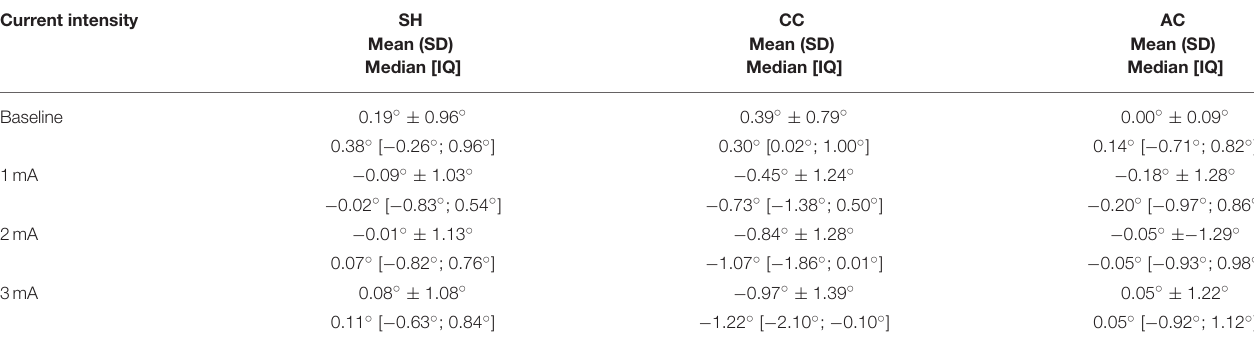
TABLE 2 | Descriptive data of subjective visual vertical (SVV) for each HD-tDCS 3 × 1 condition and current intensity. Current